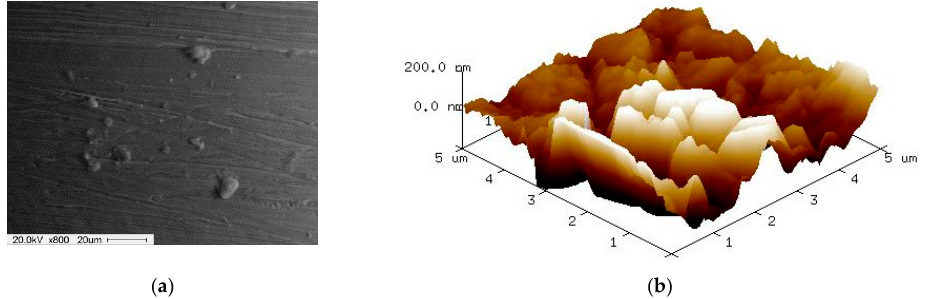
Figure 9. SEM and AFM surface images of 316L stent wires (Ra: 0.23 µm). ( a ) SEM surface image before finishing; ( b ) AFM surface image before finishing.